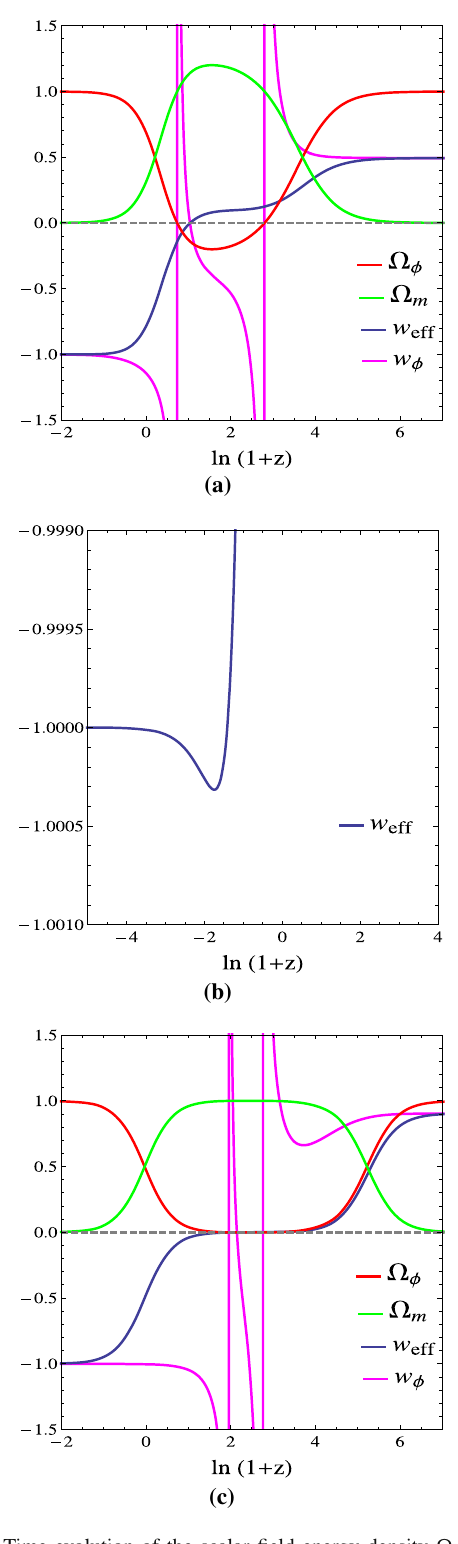
Fig. 4 Time evolution of the scalar field energy density (cid:8) φ , matter energy density (cid:8) m , effective EoS w eff and EoS of scalar field w φ for a generic scenario (II). In a we have taken w = 0 , n = 4 ,ξ = 0 . 1, b A closer look on the evolution of w eff given in a at late time, c w = 0 , n = 4 ,ξ = 0 .